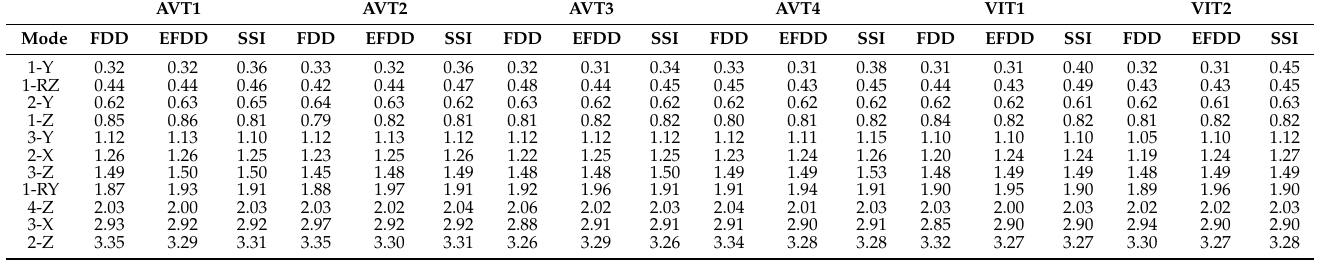
Figure 14. Three-axle 32-ton truck moving at a speed of 40 km/h on the Tablazo bridge.